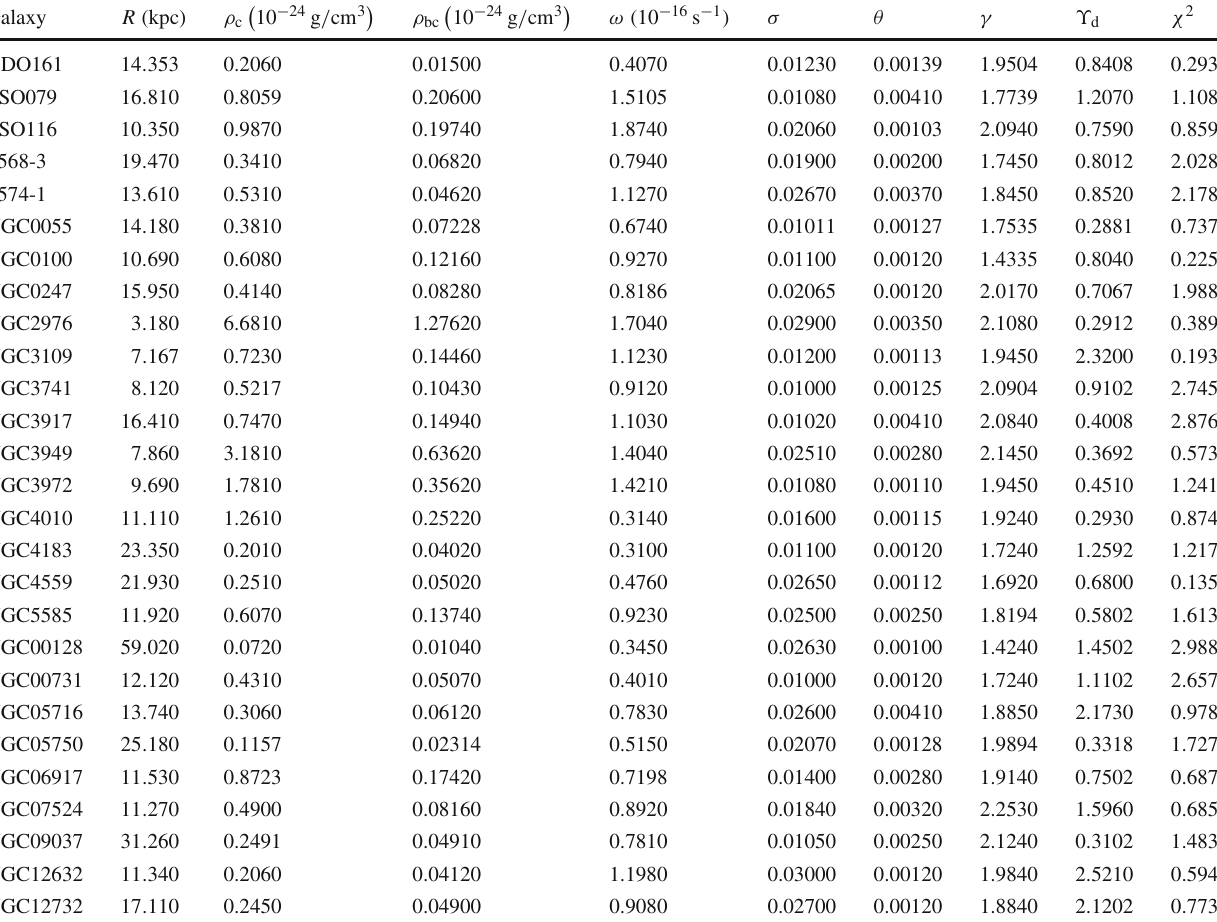
Table 1 Optimal parameters for 27 bulgeless SPARC galaxies. In the Table R denotes the static radius of the condensate, ρ c is the central density of the dark matter, ρ bc is the central density of the baryonic matter, ω is the angular rotational velocity of the halo, σ and θ charac-